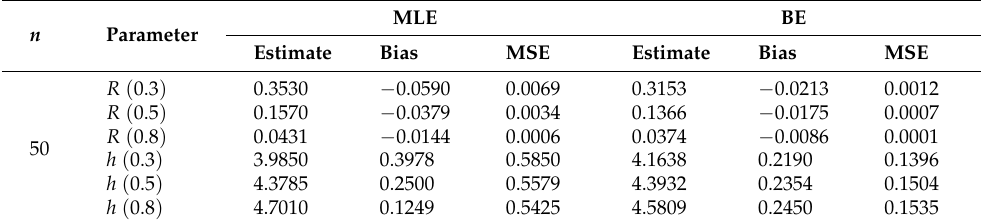
Table 8. Point estimates of R ( x ) and h ( x ) at x = { 0.3,0.5,0.8 } under Scheme